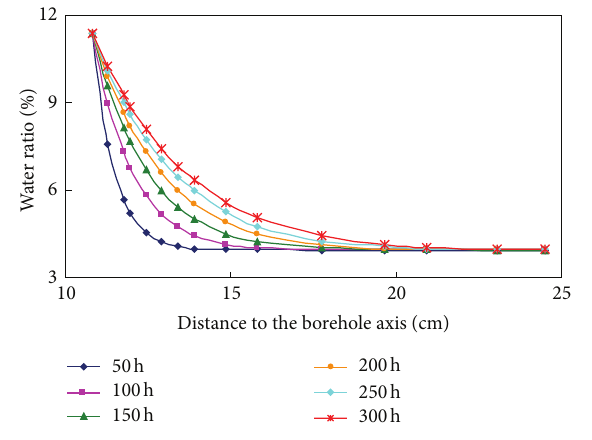
Figure 7: Water content distribution around the wellbore.